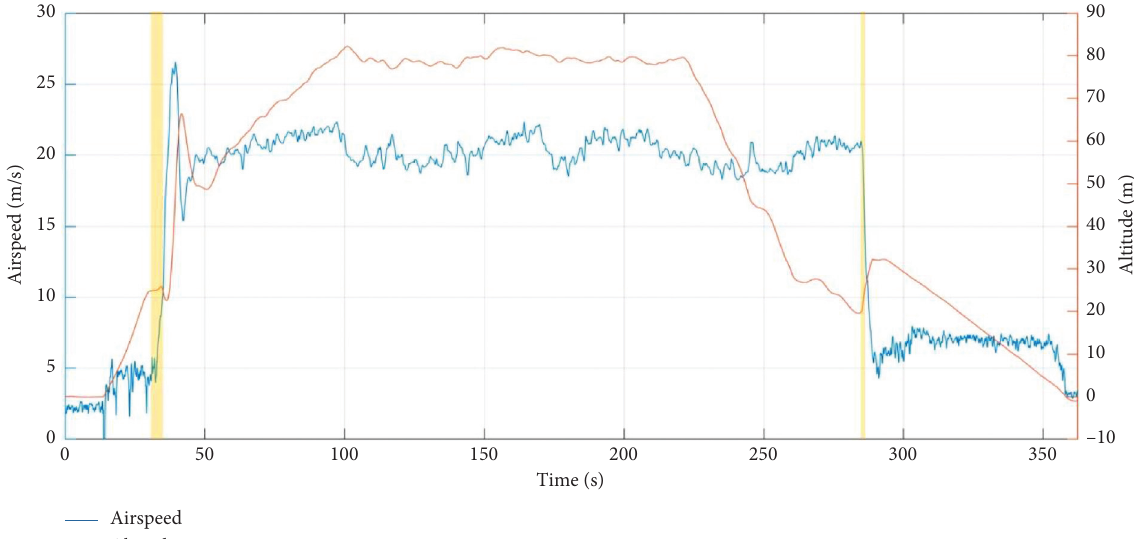
Figure 20: Airspeed and altitude of the aircraft in the flight